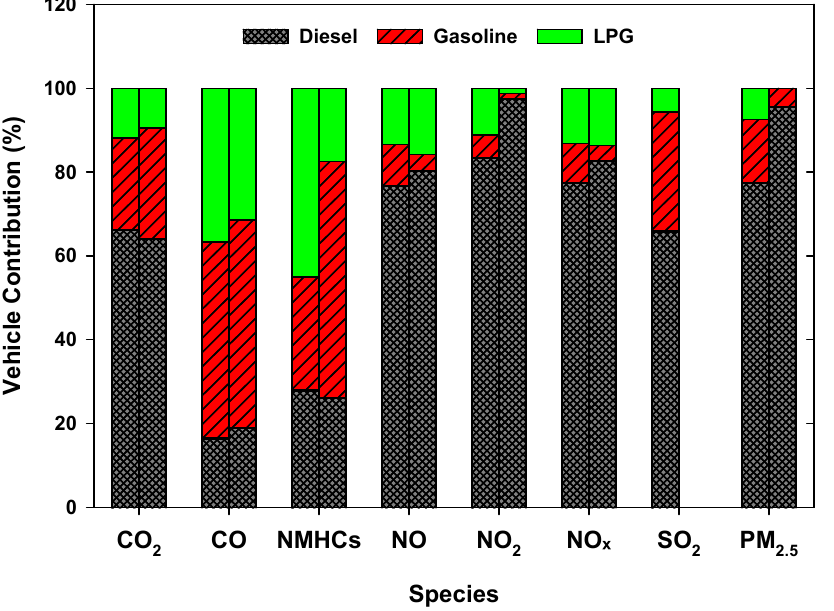
Figure 4. Relative source contribution estimates for LPG, gasoline, and diesel vehicle emissions as fractions of total vehicle emissions estimated by PMF (left bars) and EMFAC-HK (right bars). Both GV and LPG have high contributions to CO and source attributions by PMF and EMFAC-HK differed less than 15%. These two methods also apportion similar CO 2 contributions by GV and LPG. However, larger differences are found for other pollu- tants. Most of these species have the largest contributions from DV and the differences in DV contributions by PMF and EMFAC-HK led to discrepancies in LPG and GV ap- portionments. The EMFAC-HK attributed a much larger contribution of NMHCs by GV (56%) than LPG (18%), which is likely due to its unrealistic assumption that LPG and DV do not have any evaporative losses of NMHC. Figure 5 shows PMF-derived source contribution estimates for PM 2.5 concentrations in the tunnel. In addition to vehicle emissions, secondary inorganic aerosols and road dust are included. DV emissions account for over 50% of tunnel PM 2.5 mass concentra- tions, followed by secondary sulfate (~20%). Road dust (including resuspended dust as well as brake, tire, and road surface wear) contributes to ~7% of PM 2.5 mass. Although not measured, the road dust contribution to the PM 10 mass is expected to be higher due to larger-sized particles. Chemical composition analysis of PM 2.5 collected in the SMT shows that geological mineral abundances increased from 2% in 2003 to 5% in 2015, in- dicating that non-tailpipe emissions are becoming more important as tailpipe emissions decrease [28,64].